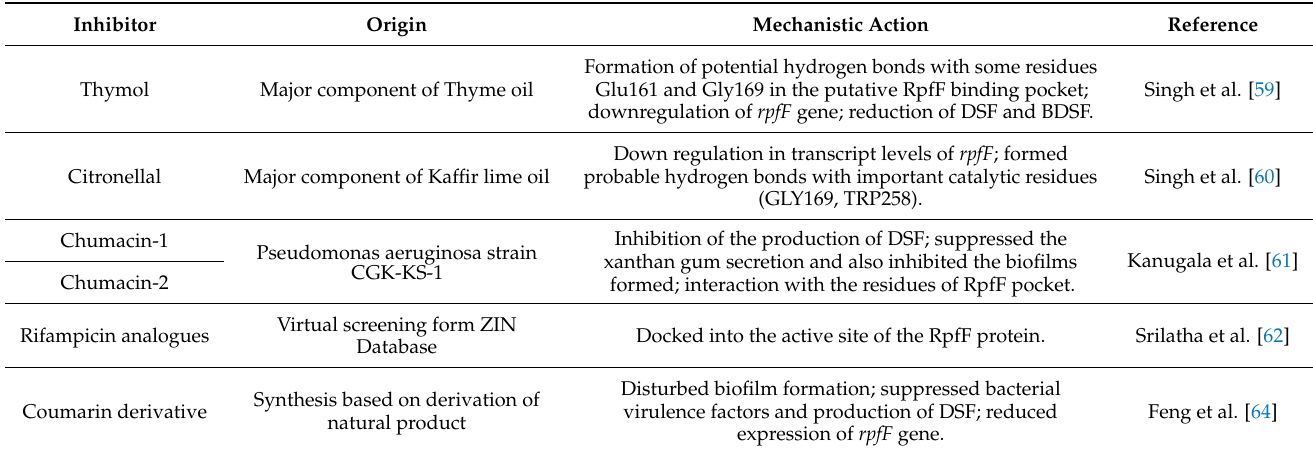
Table 1. Overview of reported RpfF